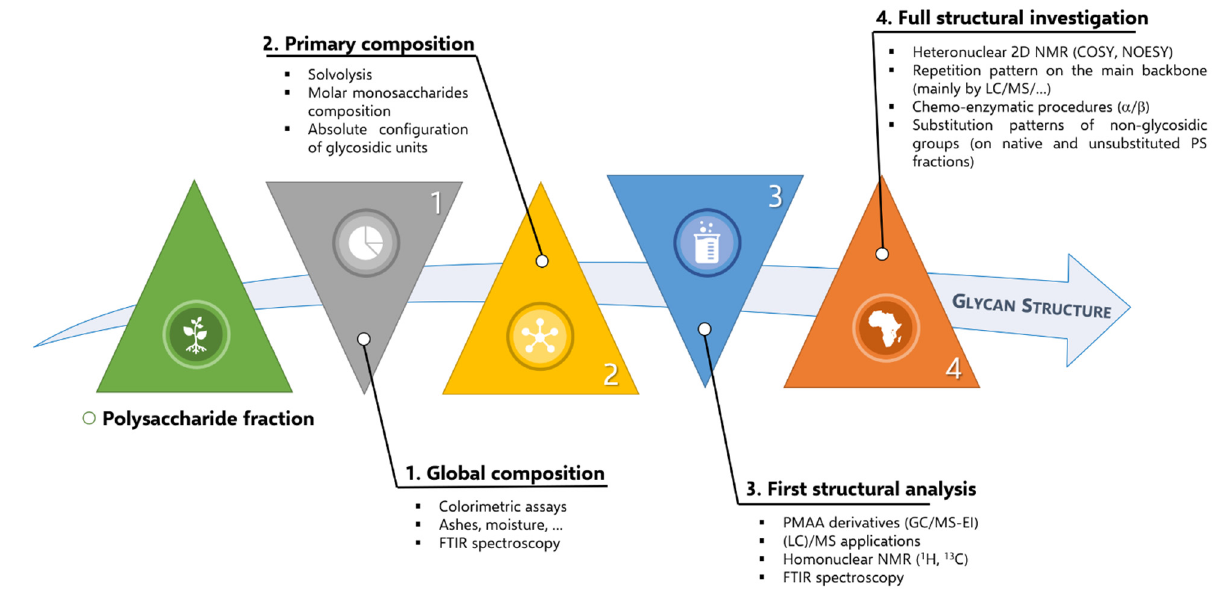
Figure 3. Determining the structural features of polysaccharides.